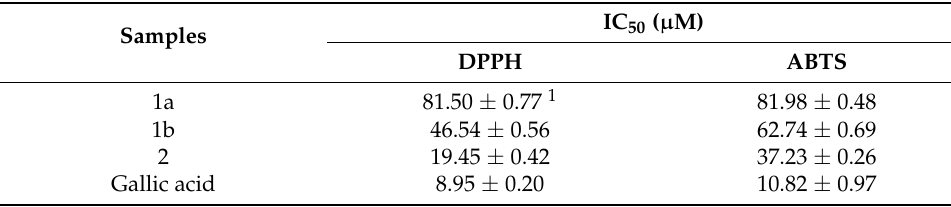
Table 2. IC 50 values for the antioxidant activities of new compounds 1a , 1b , and 2 .